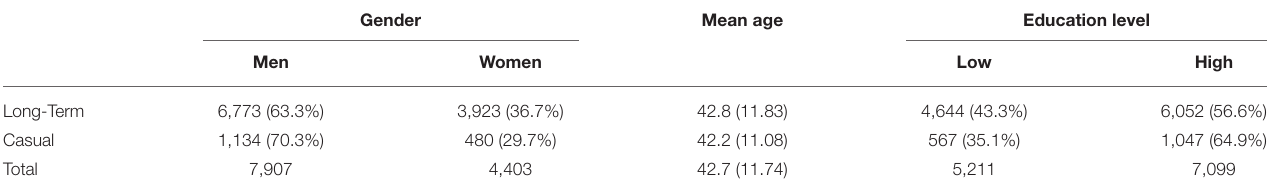
TABLE 1 | Demographic composition of the sample for both relationship seeking